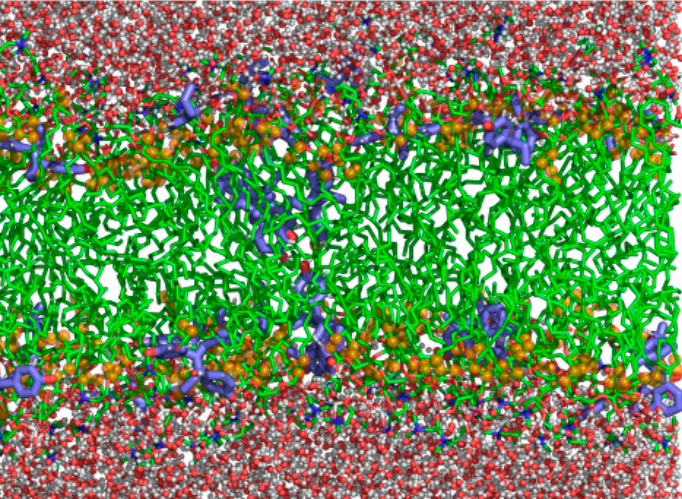
Figure 9. Representative snapshot of POPC bilayer with DES. Water molecules are depicted as balls and sticks, the POPC carbon backbone is shown as green sticks, and the DES carbon backbone is shown as blue sticks. Oxygen atoms are shown in red, and hydrogen atoms are shown in white. The C2 and C3 groups of POPC are shown as brown spheres.